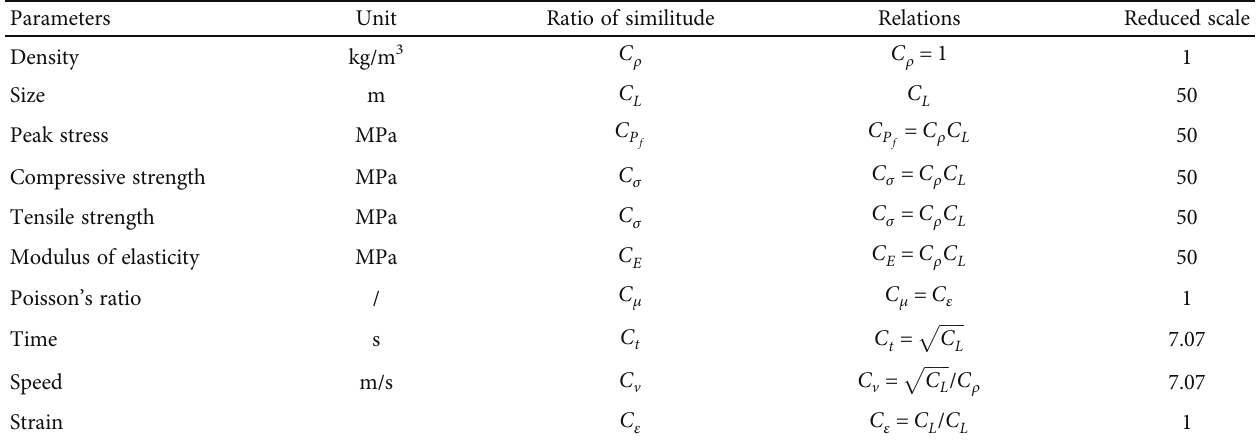
Table 1: Similarity ratio